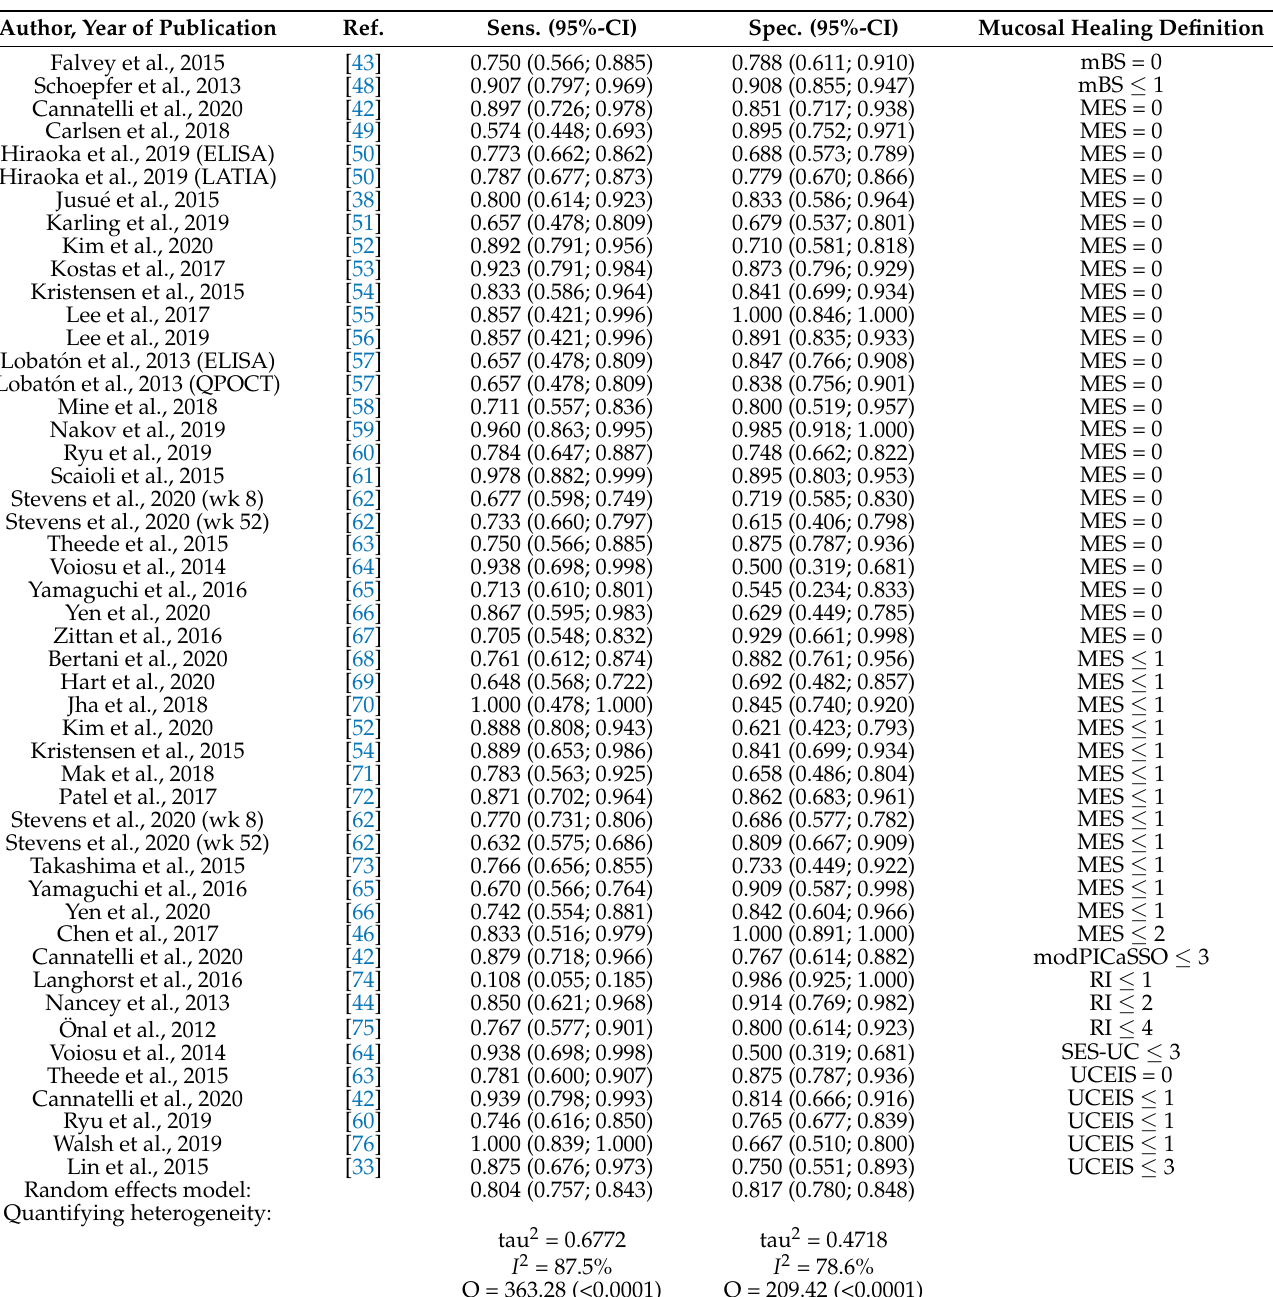
Table 2. Diagnostic test sensitivity and specificity calculated for the use of FC as the biomarker of mucosal healing in ulcerative colitis. Studies are grouped by the MH definition applied. Abbreviations: CI, confidence interval; mBS, modified Baron Score; MES, Mayo endoscopic subscore; MH, mucosal healing; RI, Rachmilewitz Index; SES-CD, Simple Endoscopic Score for Ulcerative Colitis;Sens, sensitivity; Spec, specificity;UCEIS, Ulcerative Colitis Endoscopic Index of Severity. Notes: Stevens et al. compared diagnostic tests after 8 and 52 weeks of treatment (wk 8 andwk52, respectively). Hiraoka et al. compared ELISA and latex agglutination turbidimetric immunoassay (LATIA) kits; Lobat ó n et al. compared ELISA and Q-Point Of Care Tests